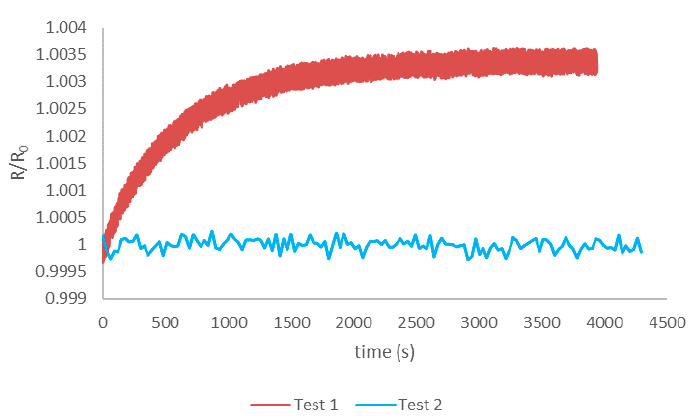
Figure7. Resistance measurement over time at constant ambient temperature (25 °C) with a meas- urement current of 1 mA and a signal length of 2 ms at a measurement frequency of 4 Hz (Test 1) and 0.03 Hz (Test